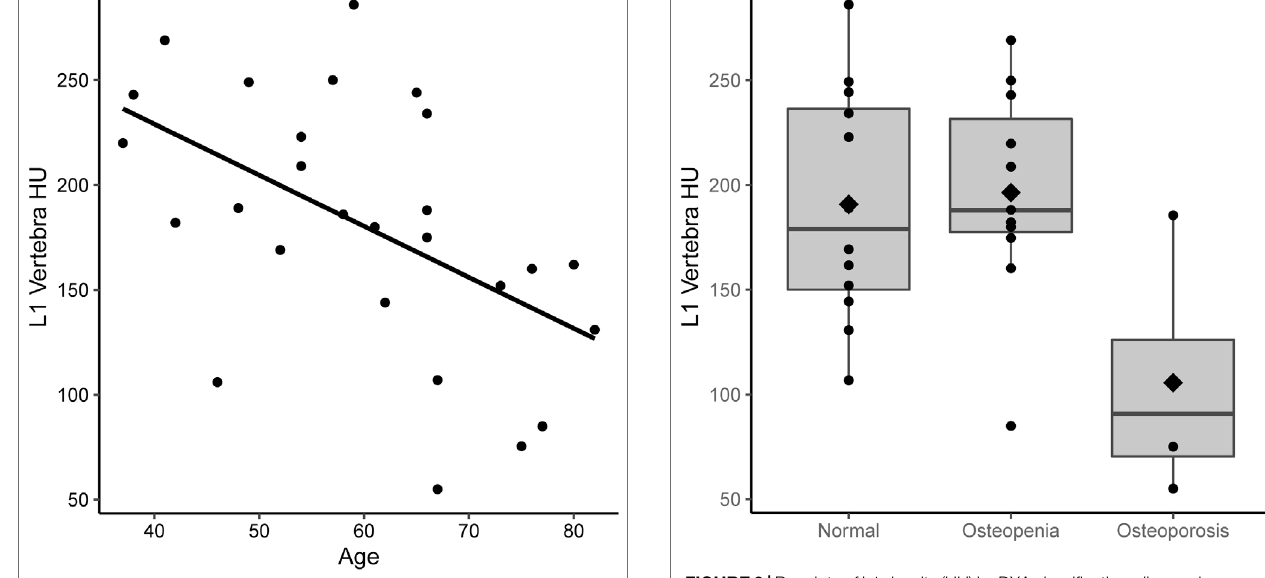
Houns fi eld Units (HU) at the L1 vertebra] in subjects with CP.